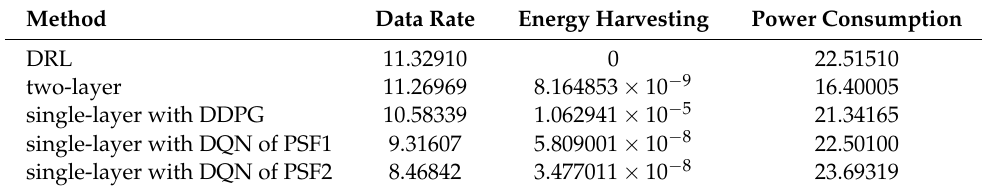
Table 3. Performance comparison with M = 32.